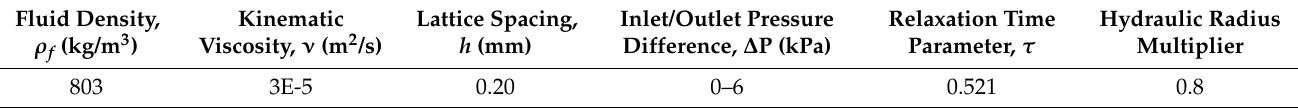
Table 4. Lattice-Boltzmann Method (LBM) parameters used for the fluid simulation in sand production tests. Fluid Density, ρ f (kg/m 3